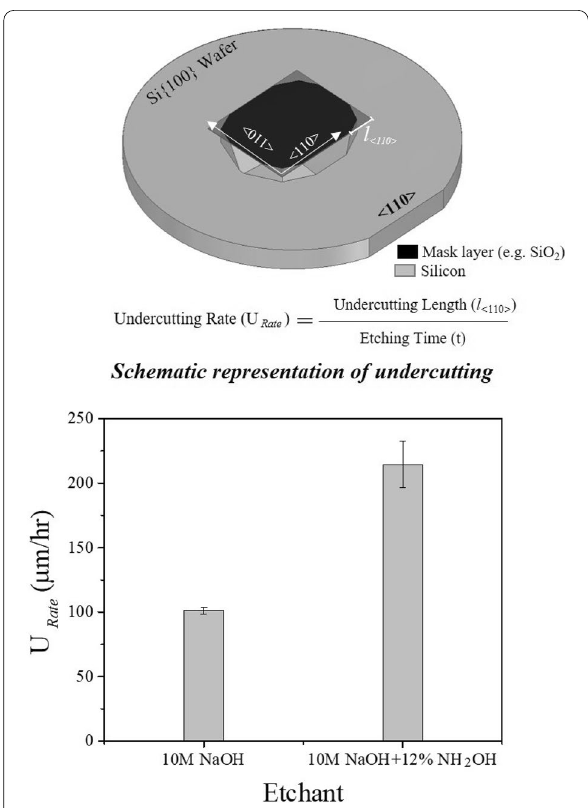
Fig. 3 Undercutting rate in 10 M NaOH without and with addition of 12% NH 2 OH at 70